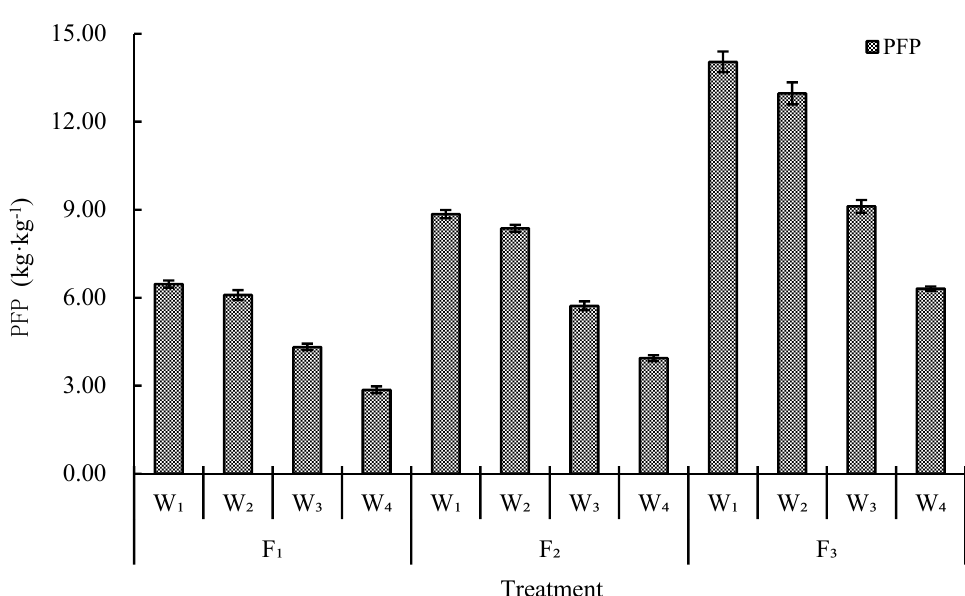
Figure 8. Effects of different water and fertilizer treatments on partial factor productivity (PFP) of young apple trees in 2013. Fertilizer and the interaction with water had a very significant impact on PFP ( p < 0.01).